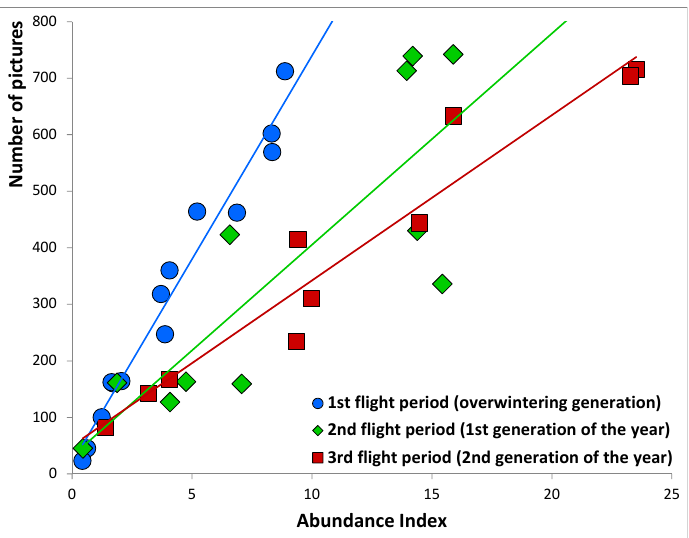
Figure A3. Relation between the abundance of peacock butterflies in Belgium by week and the number of pictures submitted in that week for each of the flight peaks.